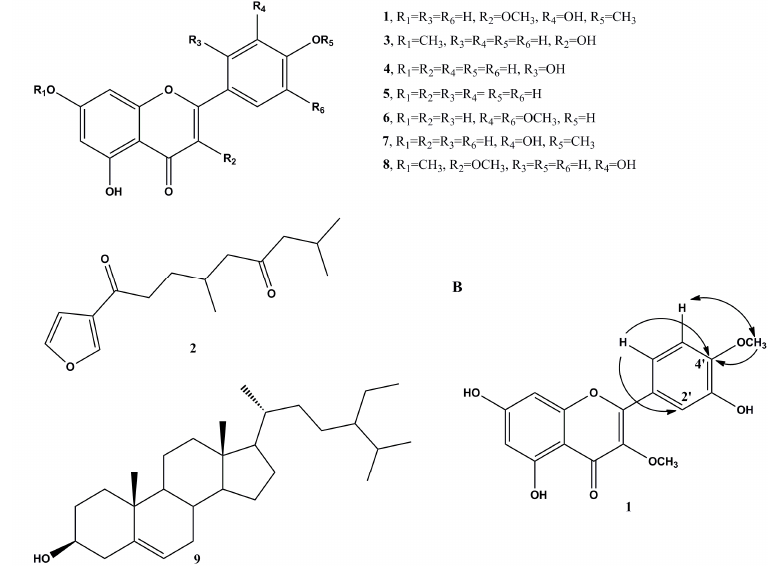
Figure 1. Compounds isolated from M. bontioides . ( A ) Chemical structures of compounds 1 – 9 ; and ( B ) key HMBCs (H → C) and selected NOESY (H ↔ H) correlations of compound 1 .